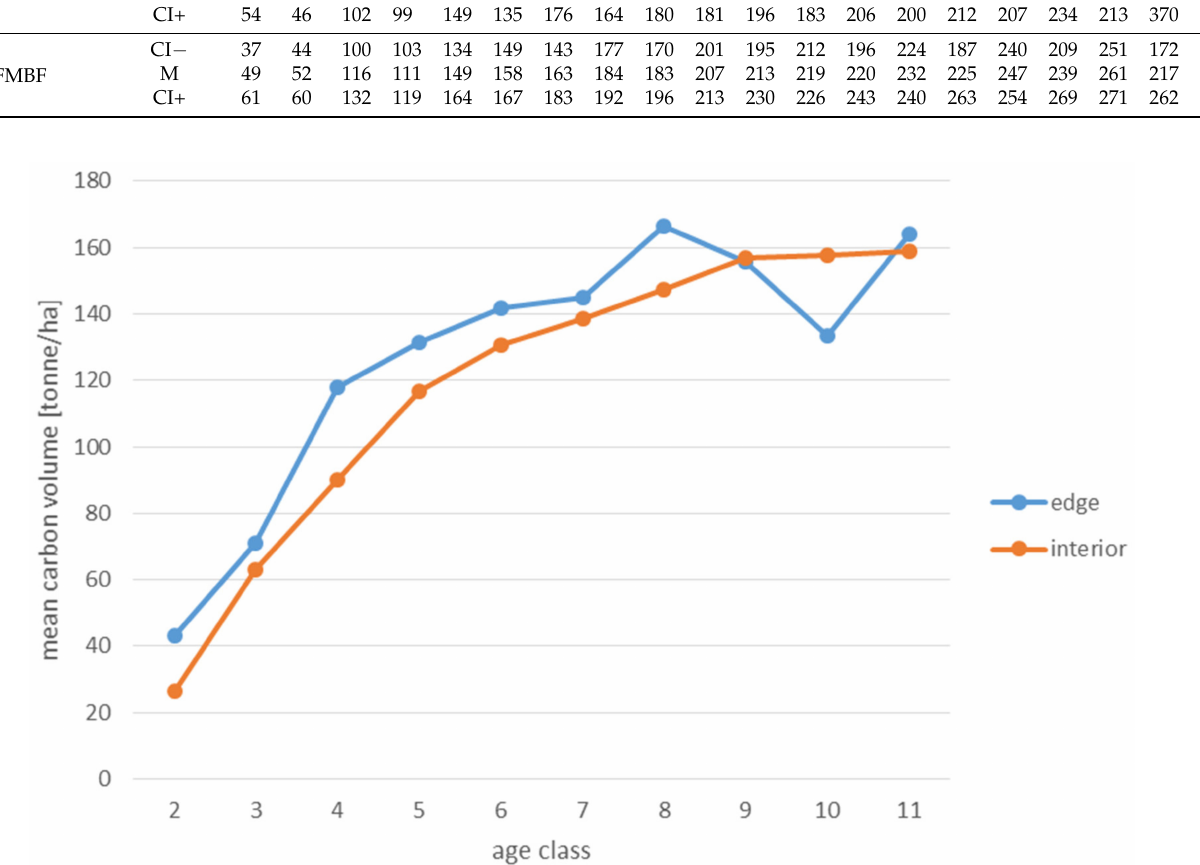
Figure 6. Changes in the mean carbon volume density in the site of FCF, divided into the edge and interior